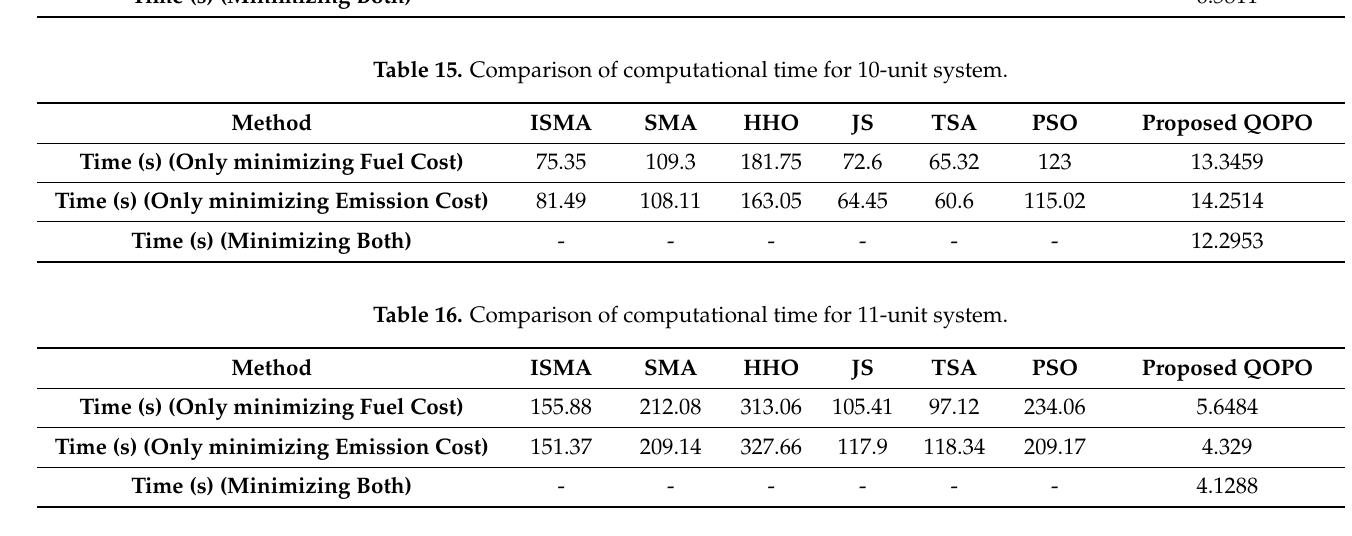
Table 17. Comparison of computational time for 40-unit